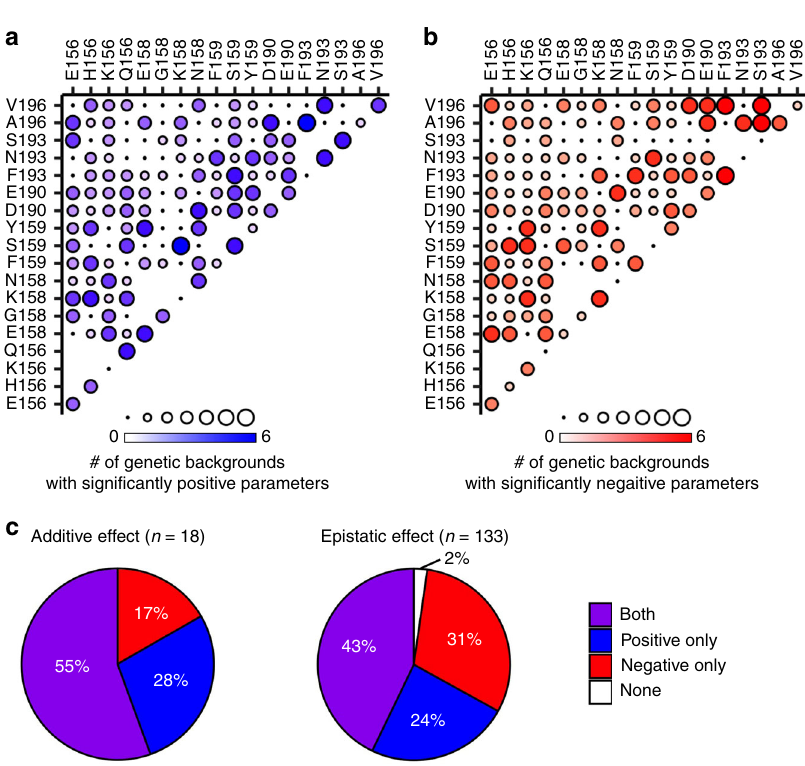
Fig. 4 Inference of additive and pairwise epistatic effect. Additive effect for each single amino acid variant and pairwise epistatic effect for each double amino acid variant are inferred based on the deep mutational scanning data. a , b For each additive effect and pairwise epistatic effect, the number of genetic backgrounds (out of six, Supplementary Fig. 6) that have an a signi fi cantly positive parameter or b negative parameter at 95% con fi dence interval are shown. The identity of a given double amino acid variant is represented by the labels on the x - and y-axes. For example, double amino acid variant E156/V196 is represented by the circle at the top left corner of the graph. Additive effects, which describes fi tness contribution from a single amino acid variant, are shown on the diagonal, where the x - and y -axis labels are the same. For example, single amino acid variant E156 is represented by the circle at the bottom left corner of the graph, where both the x - and y -axes are E156. No circle is shown where the x - and y -axis labels represent the same residue position but different amino acid variant (e.g., E156/H156), which cannot occur at the same time. c Each additive effect ( n = 18) and pairwise epistatic effect ( n = 133) is classi fi ed into four categories, namely, both, positive only, negative only, and none. Both indicates both signi fi cantly positive and signi fi cantly negative parameters can be observed among those six genetic backgrounds. Additive effect of D190 is an example of both (Supplementary Fig. 6). Positive only indicates only signi fi cantly positive parameters but not signi fi cantly negative parameters can be observed. Epistatic effect of F193/A196 is an example of positive only (Supplementary Fig. 6). Negative only indicates only signi fi cantly negative parameters, but not signi fi cantly positive parameters, can be observed. Additive effect of F193 is an example of negative only (Supplementary Fig. 6). None indicates neither signi fi cantly